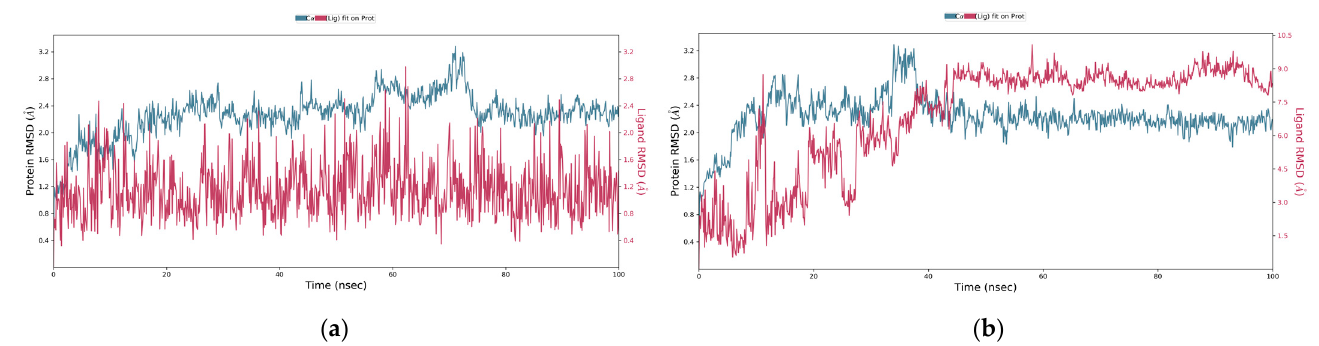
Figure 5. RMSD values of liquoric acid and limonin with receptor proteins. ( a ) RMSD of the C-alpha atoms of EGFR and liquoric acid; ( b ) RMSD of the C α atoms of caspase-9 and limonin with time. The variation in RMSD of receptor protein is shown on the y axis (on left) through time. The variation in RMSD of the ligand is shown on the y axis (on right) through time.